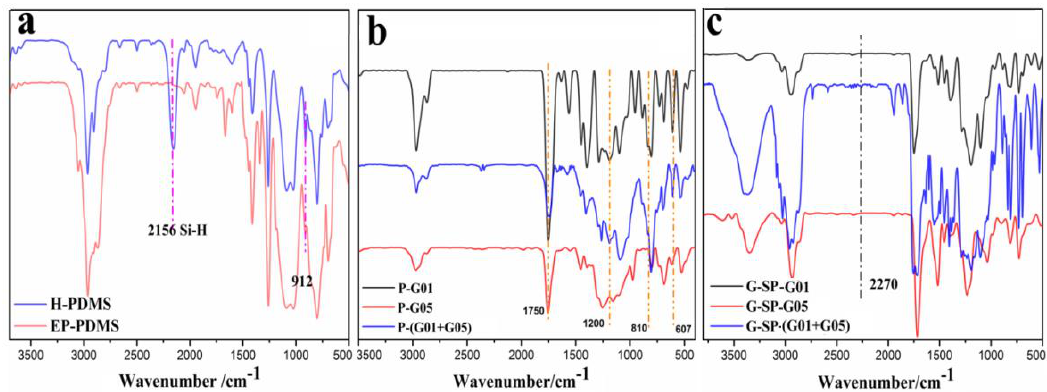
Figure 1. FTIR spectra of ( a ) H-PDMS and EP-PDMS; ( b ) P-G01, P-G05, and P-(G01+G05); ( c ) G-SP-G01, G-SP-G05, and